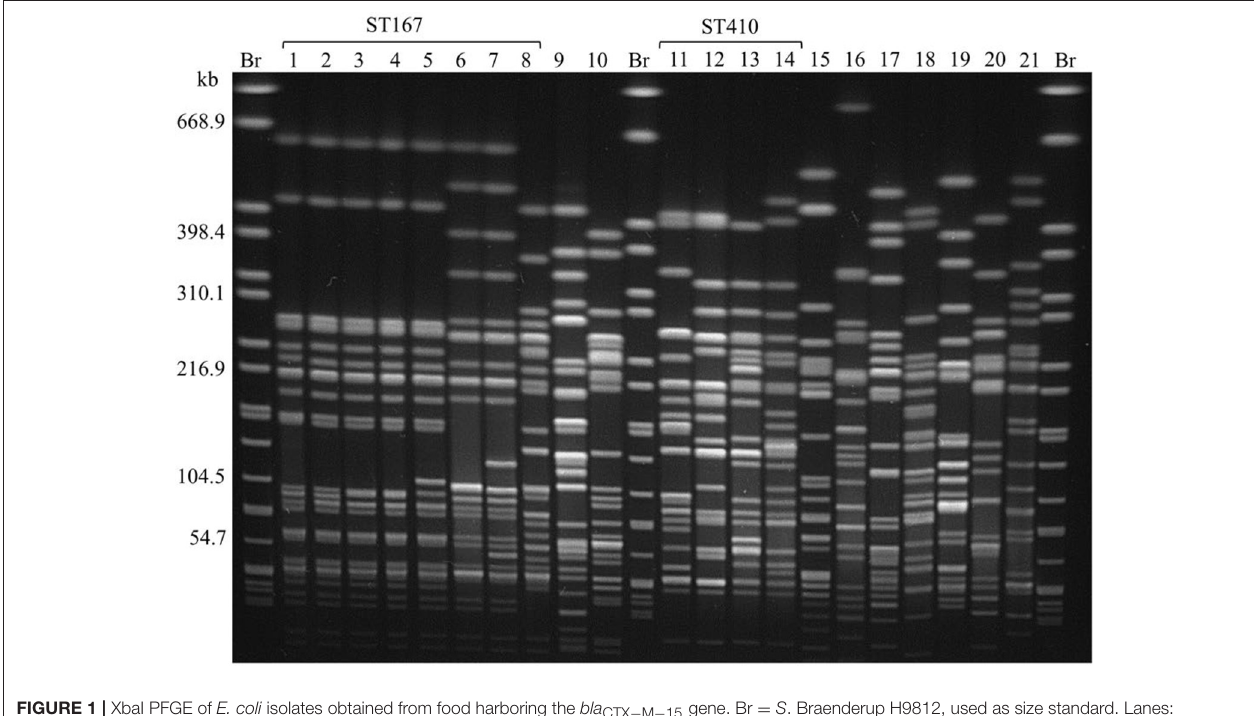
FIGURE 1 | XbaI PFGE of E. coli isolates obtained from food harboring the bla CTX − M − 15 gene. Br = S . Braenderup H9812, used as size standard. Lanes: 1: RL16